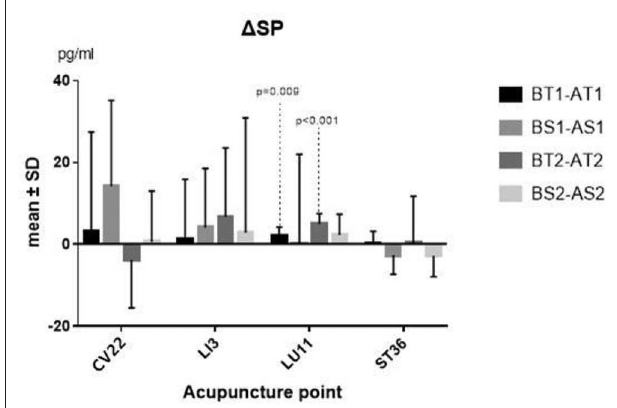
FIGURE 3 | 1 SP. BT1 means before TEA in sequence 1; AS2 means after sham-TEA in sequence 2. 1 = baseline—after TEA/sham-TEA.